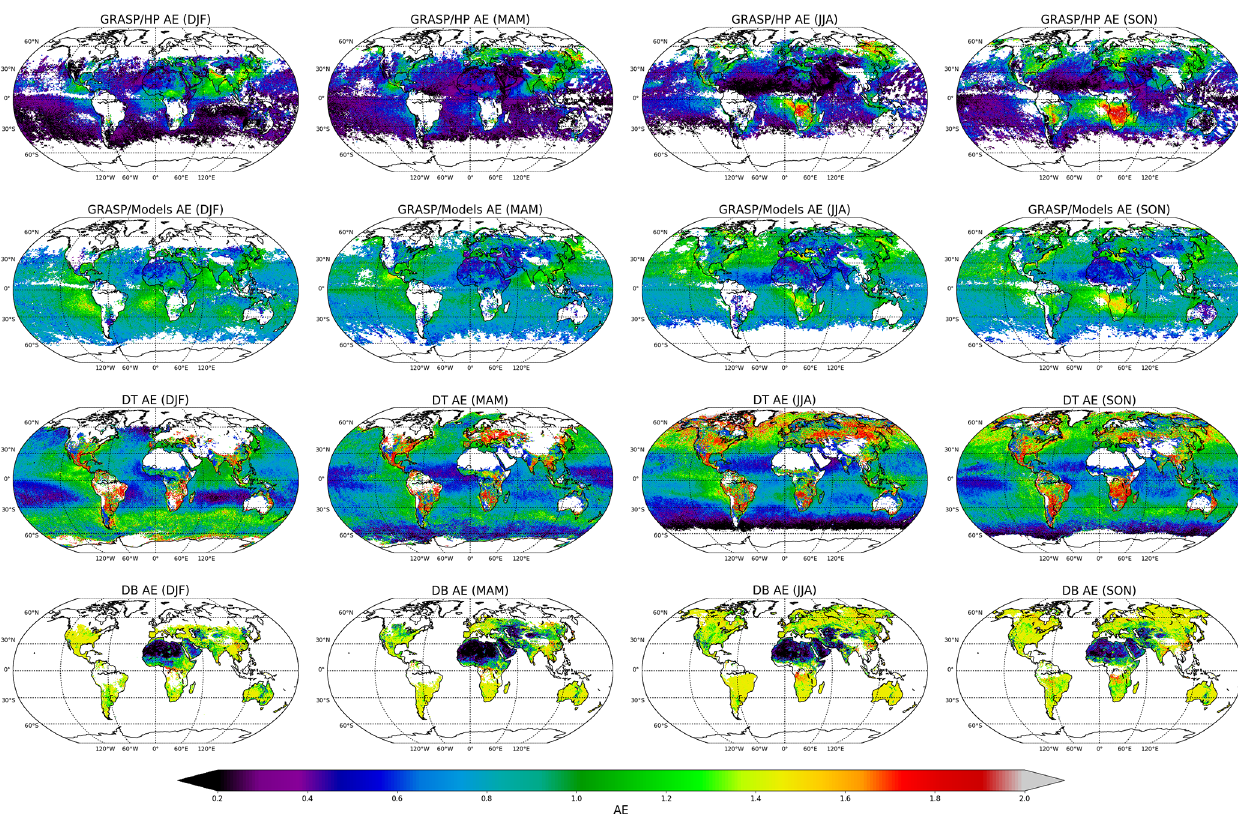
Figure 23. Spatial distribution of 0.1 ◦ × 0.1 ◦ seasonal AE from PARASOL (GRASP/HP and GRASP/Models) and MODIS (DT and DB) products.